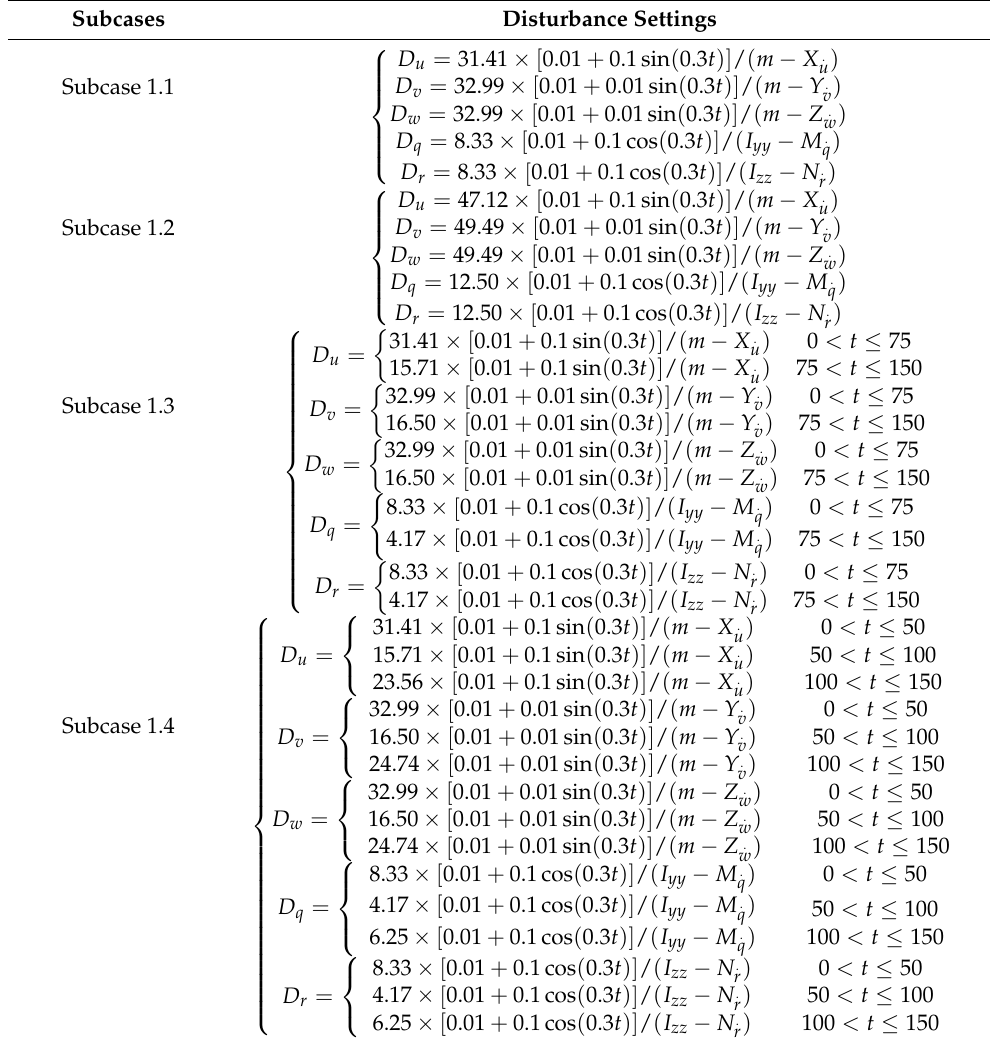
Table 5. Disturbance settings of the four subcases in case